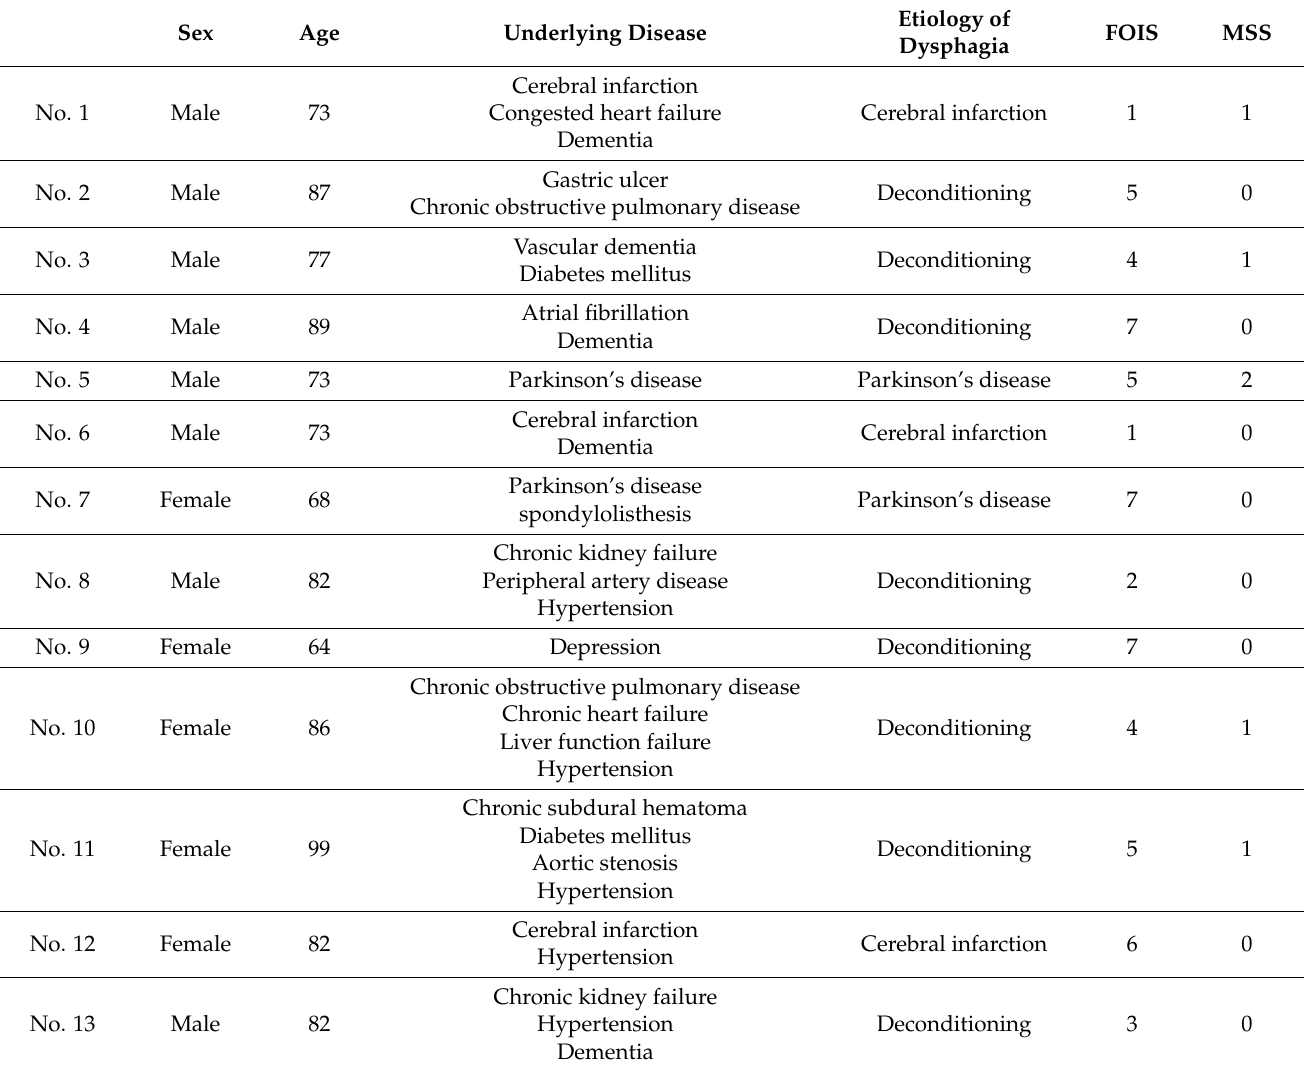
Table 1. Patient